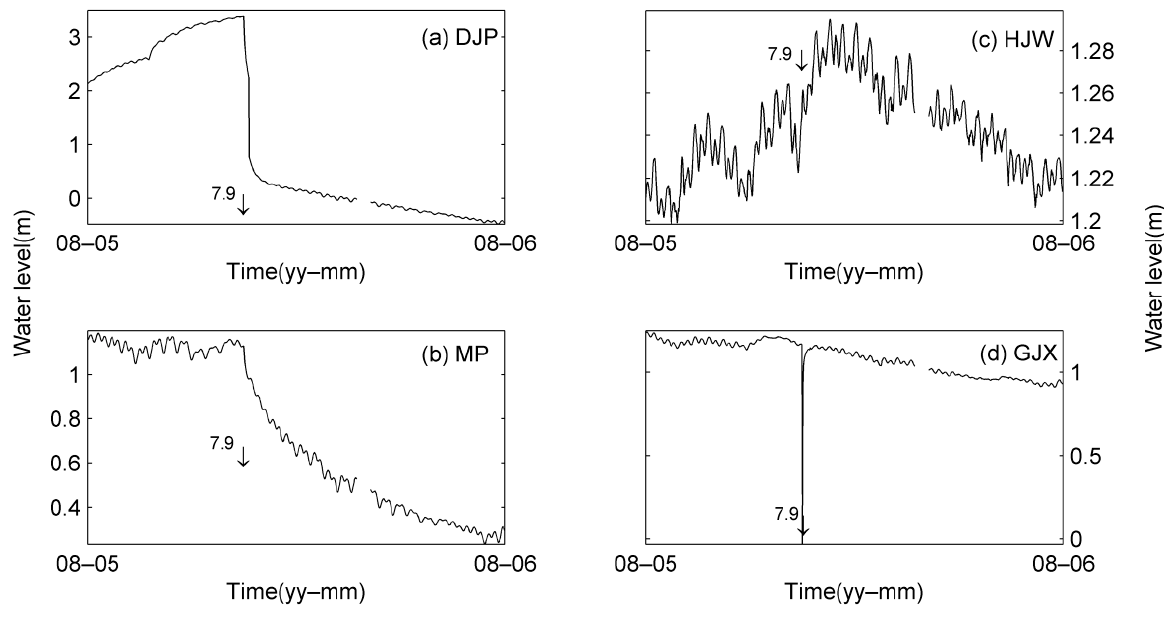
Figure 4. Water level changes induced by the 12 May 2008, Wenchuan M W 7.9 earthquake. The arrow represents the origin time of the earthquake.